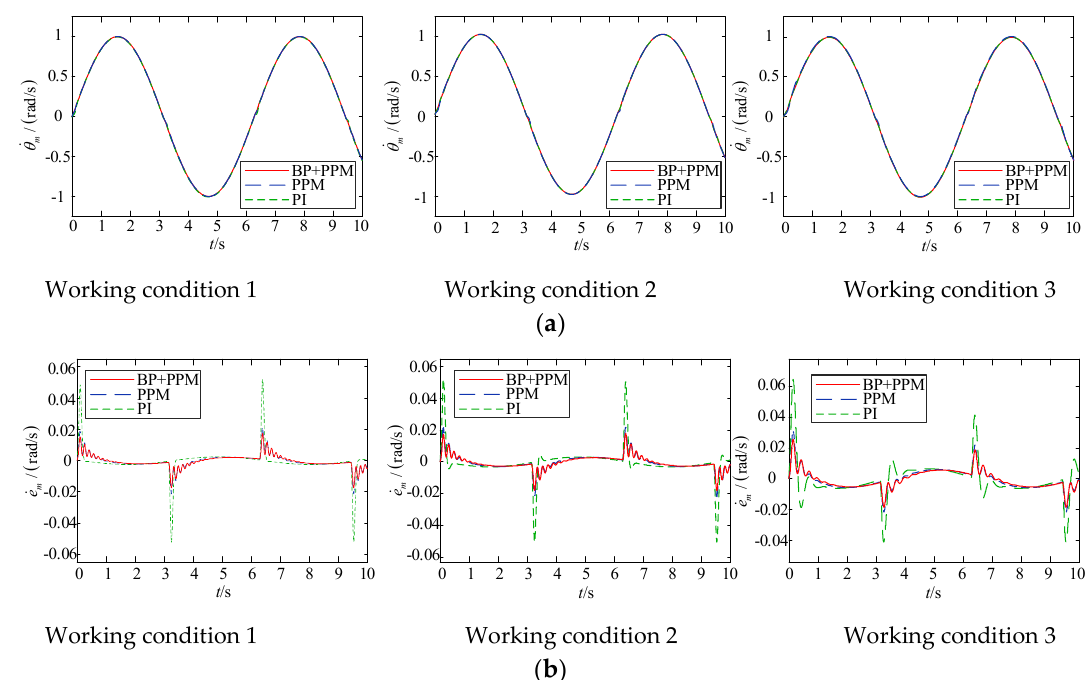
Figure 13. Motor output under different control strategies. ( a ) Rotation speed at the motor end. ( b ) Rotational speed error at the motor